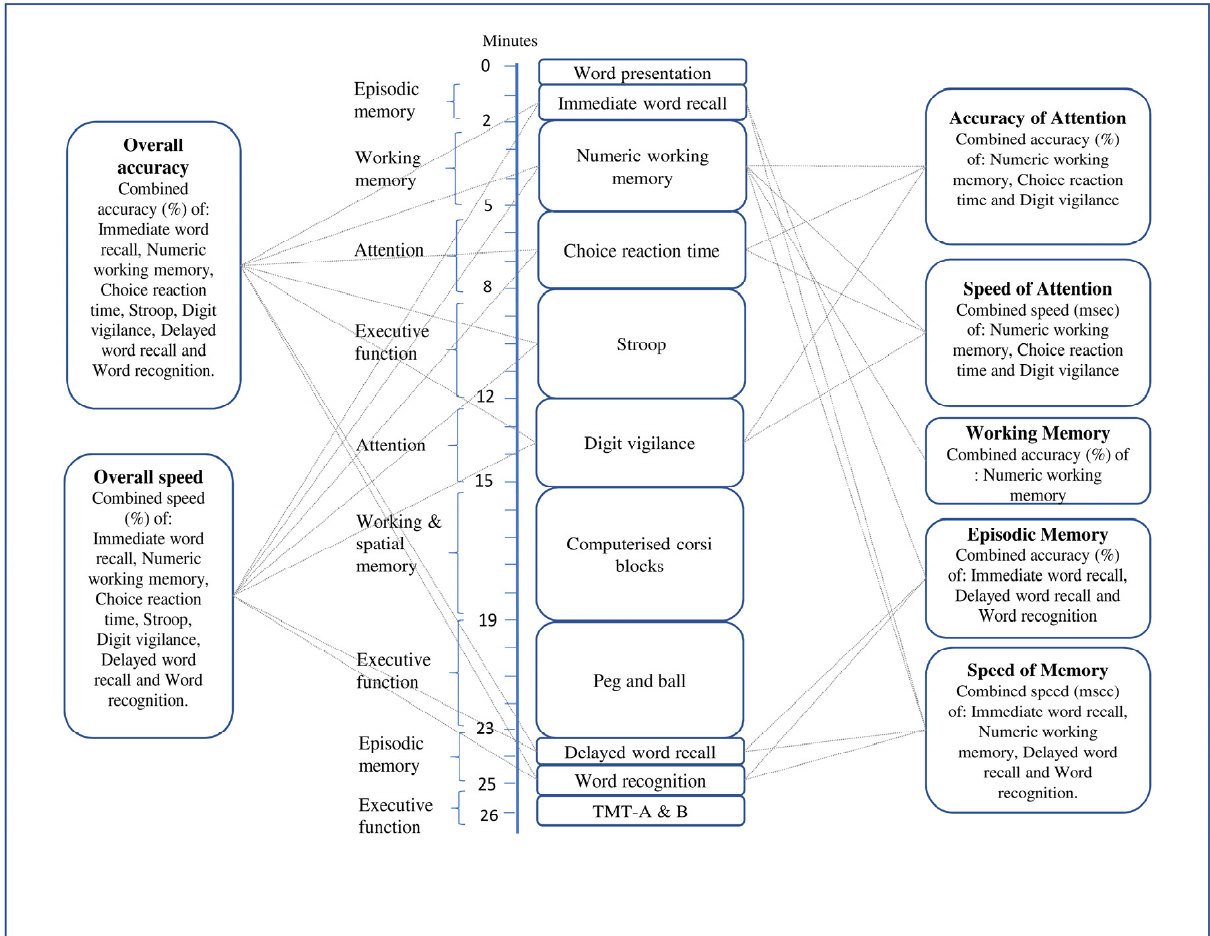
Figure 1. Cognitive task